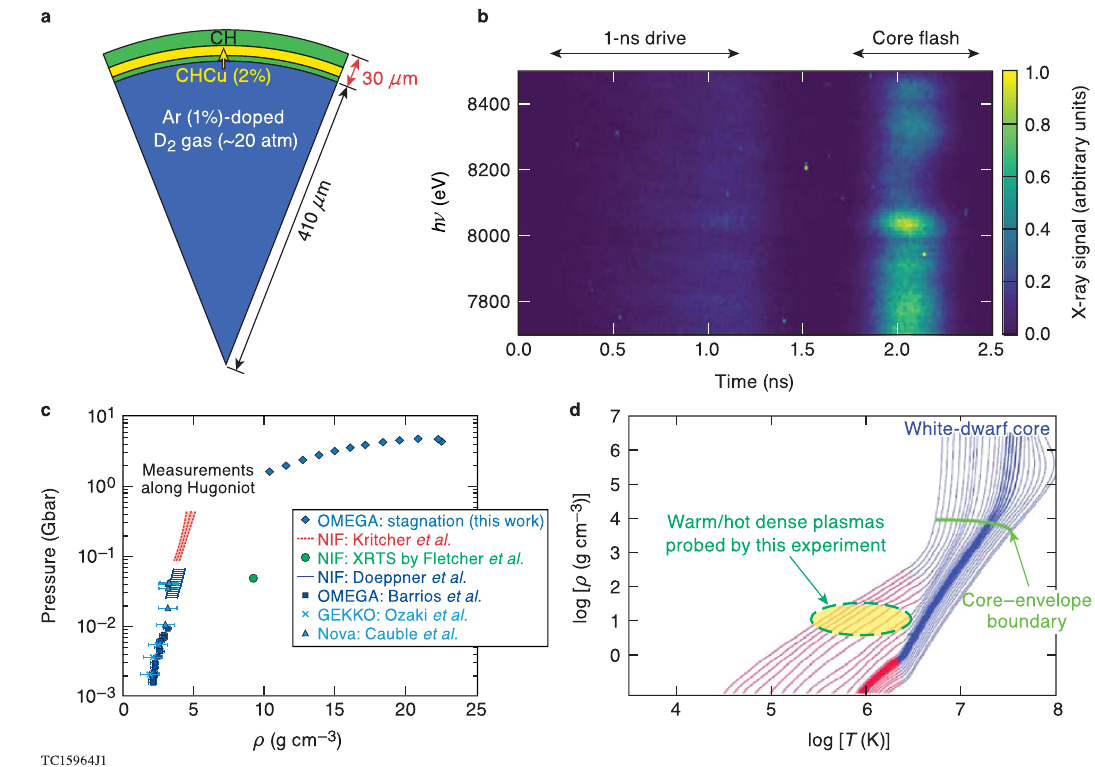
Fig. 2 | Time-resolved x-ray spectroscopy experiment of warm-/hot-dense plasmas at white-dwarf ’ s envelope conditions of Gbar pressures. a Schematic targets for implosion spectroscopy on OMEGA. b Example of streaked spectra measured in experiments. c The pressure-density region probed by various HED experiments: GEKKO 47 , OMEGA 48 , Nova 45 , NIF by Doeppner et al. 11 , NIF by Kritcher et al. 51,52 , NIF by Fletcher et al. 49 , as well as non-Hugoniot work by Doeppner et al. 50 on NIF. d The density-temperature conditions of a typical white dwarf of 0.6M ʘ